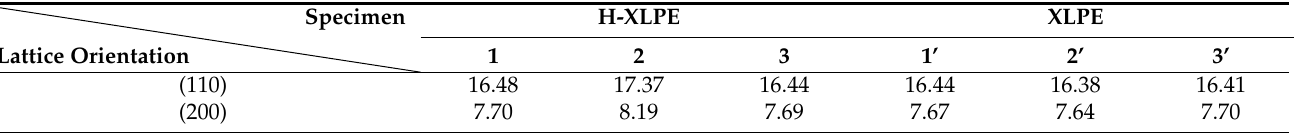
Table 1. Microcrystal size of the various position of H-XLPE bilayer and XPLE (unit: nm). Specimen Lattice Orientation